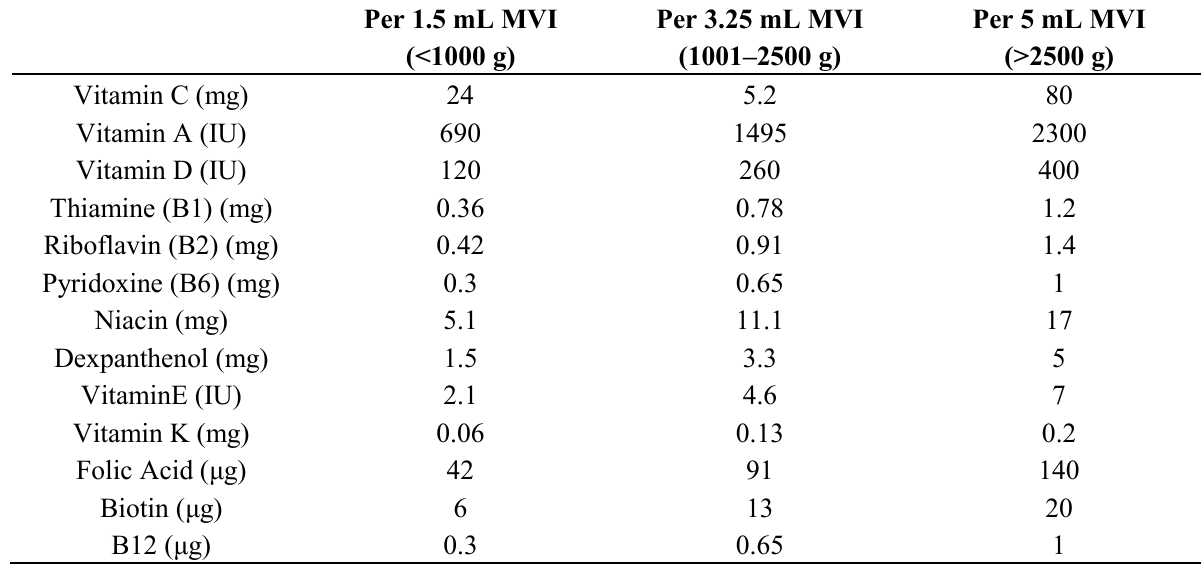
Table 4. Vitamin Levels Provided by Current Dosing of Pediatric